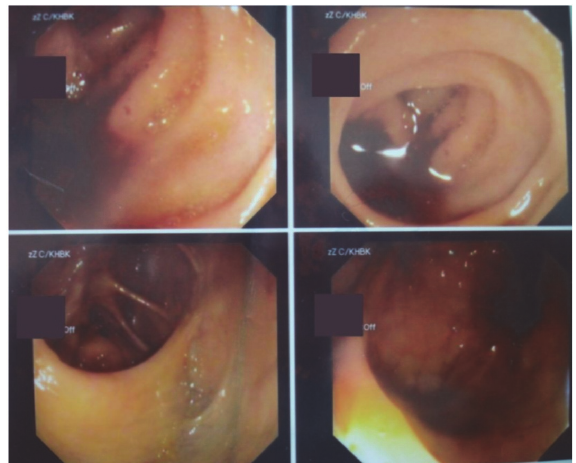
Figure 2: Imaging through colonoscopy. No signs of inflammation until the point of 10cm proximally to the ileocecal